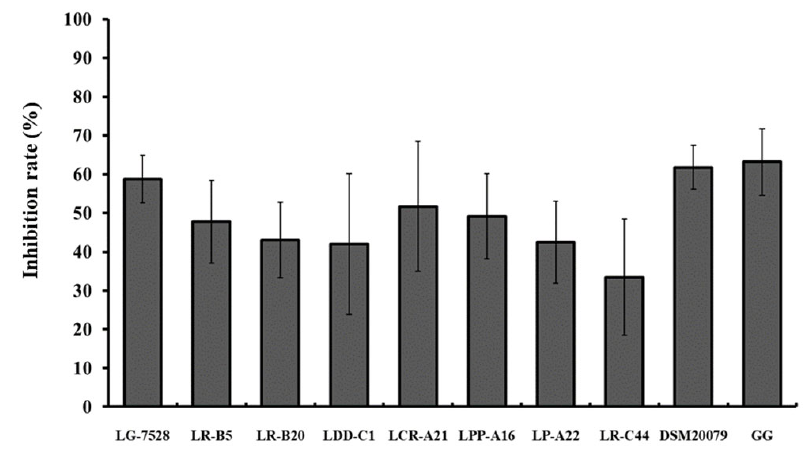
Figure 5. Effect of different lactobacilli strains on Caco-2 invasion by L. monocytogenes EGDe in a competition assay, where the antagonistic bacteria were added to the Caco-2 cells at the same time. Data represent the mean values ± standard error of the mean (SEM) of three biological and two technical replicates.